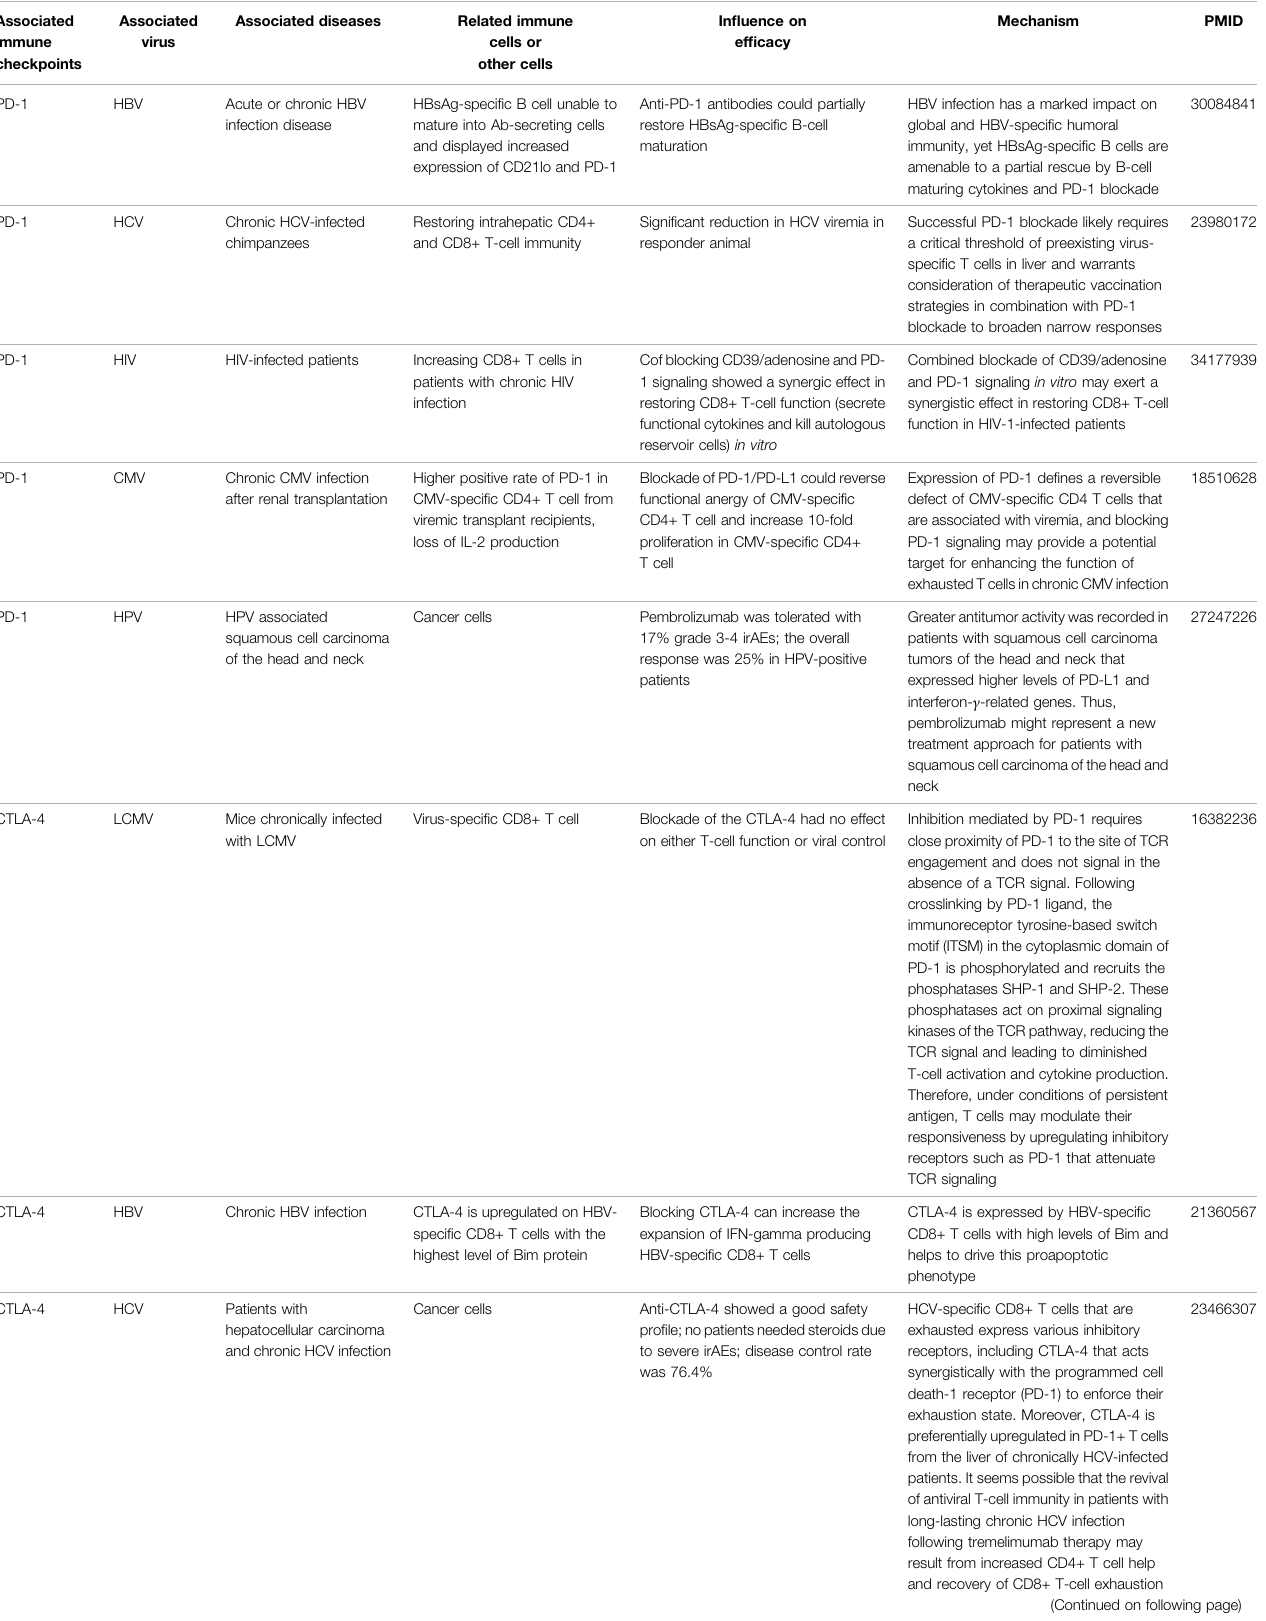
TABLE 3 | The role of immune checkpoints in virus infection